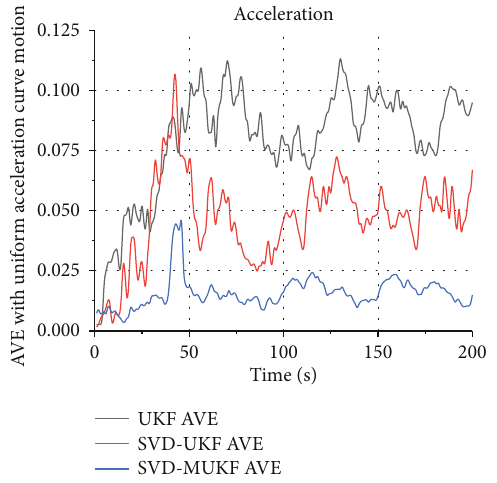
Figure 11: AVE with uniform acceleration curve motion Table 7: Mean, variance, and RMSE of algorithm acceleration data. Filter